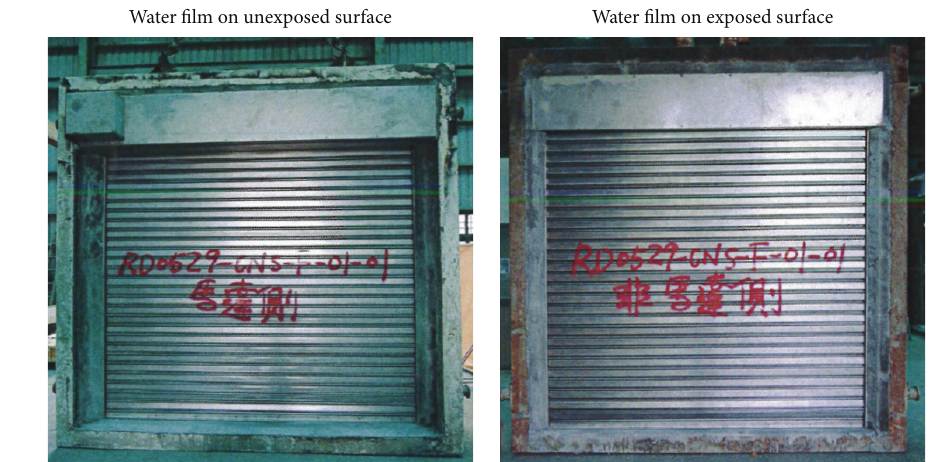
tank. The water supply pump injects water into the perforated pipe to spray water film, forming recycling. a